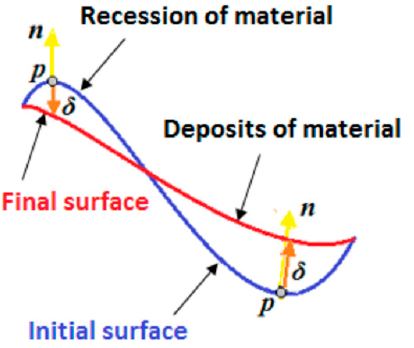
Figure A1. Modeling an erosion process on the surface of a stone. Table A1. Stone slab material and associated experiments. Considered Stone Slabs for the